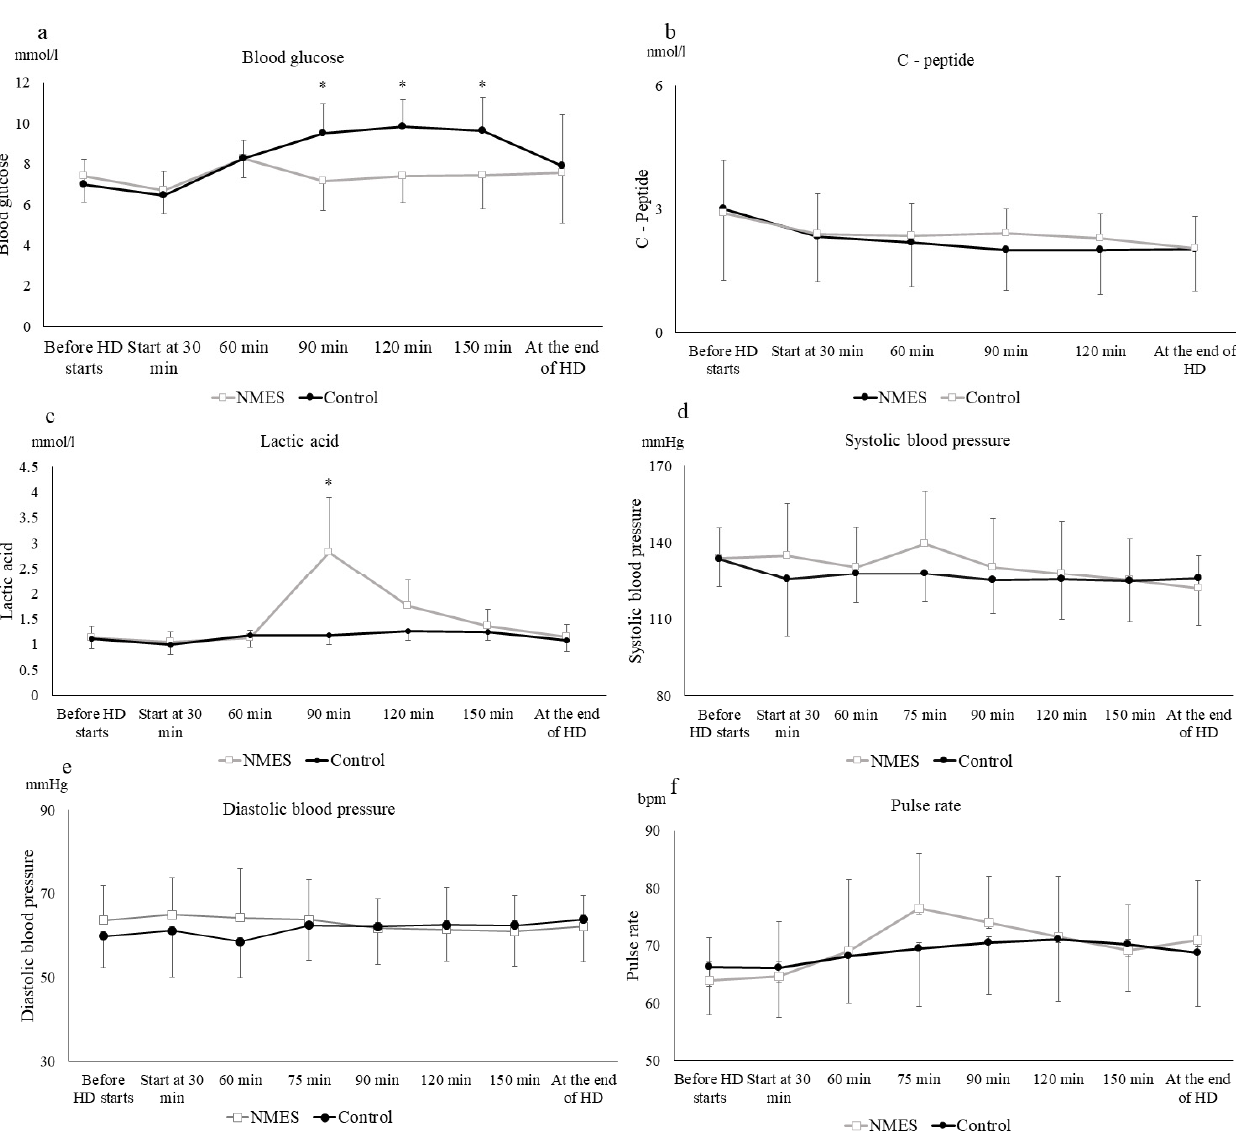
Figure 1. Serial change of each parameter in stage 1. Serial changes in blood levels of glucose ( a ), C-peptide ( b ), lactic acid ( c ), along with systolic blood pressure ( d ), diastolic blood pressure ( e ), and pulse rate ( f ) by a single bout of neuromuscular electrical stimulation (NMES) implemented after supplementary nutrient inoculation in 11 hemodialysis patients studied on two occasions: black circles, control trial; white squares, neuromuscular electrical stimulation (NMES) trial. All the participants took nutritional supplements 30 min after the start of hemodialysis (HD). NMES was performed from 60 min after the start of hemodialysis until 90 min. Values represent the mean ± standard deviation for the 11 participants. * p < 0.01 vs. control.